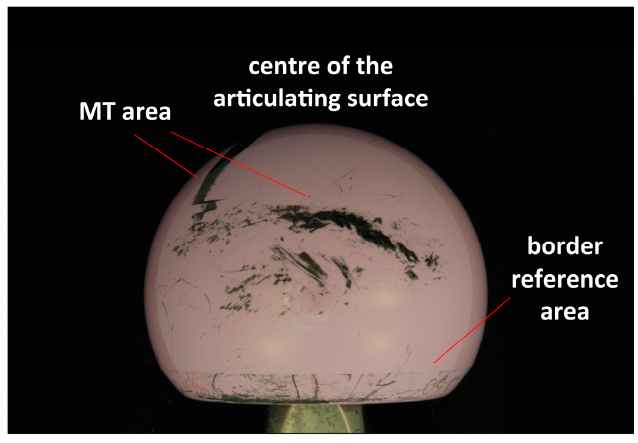
Figure 1. Areas of the femoral head where the spectra were taken.